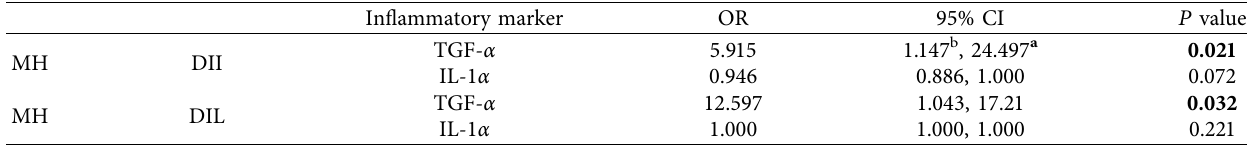
Table 5: The association of TGF- α and IL-1 α with DII and DIL, and metabolically healthy with metabolically unhealthy as the reference group in overweight and obese women ( N � 228).